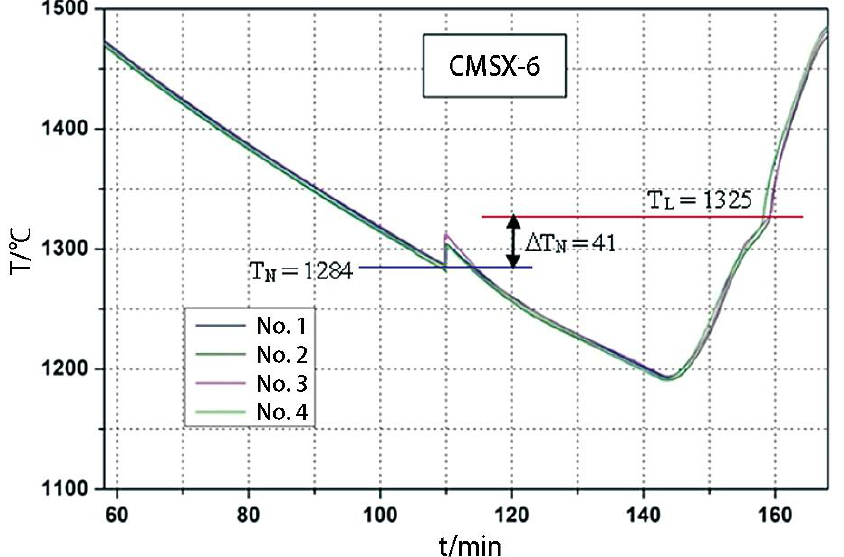
Figure 4. Temperature curves of the four samples of alloy CMSX-6 (No. 1 to No. 4 ), recorded in